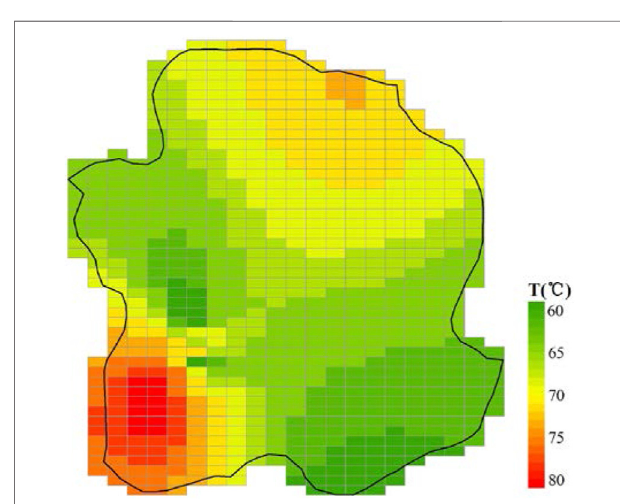
Frontiers in Earth Science |